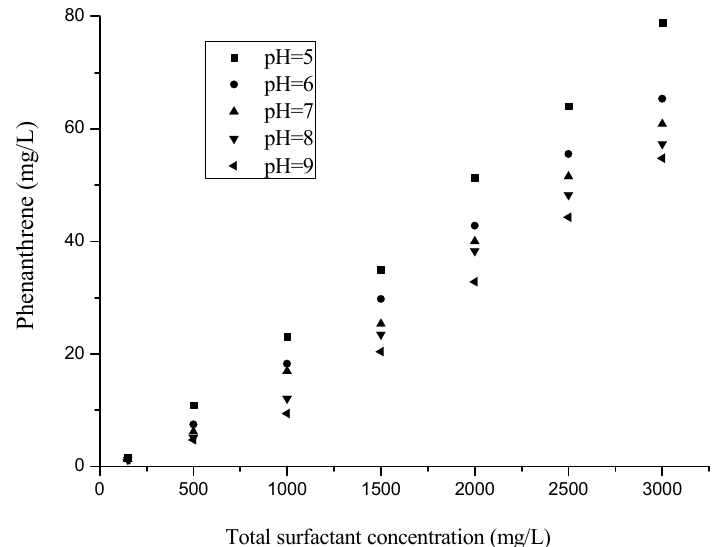
Figure 3. Solubilization of phenanthrene with different pH value (5, 6, 7, 8, 9) in the TX100–Rham mixture at CMC, 500, 1000, 1500, 2000, 2500 and 3000 mg/L (the mass ratio between TX100 and rhamnolipids was 3:1).